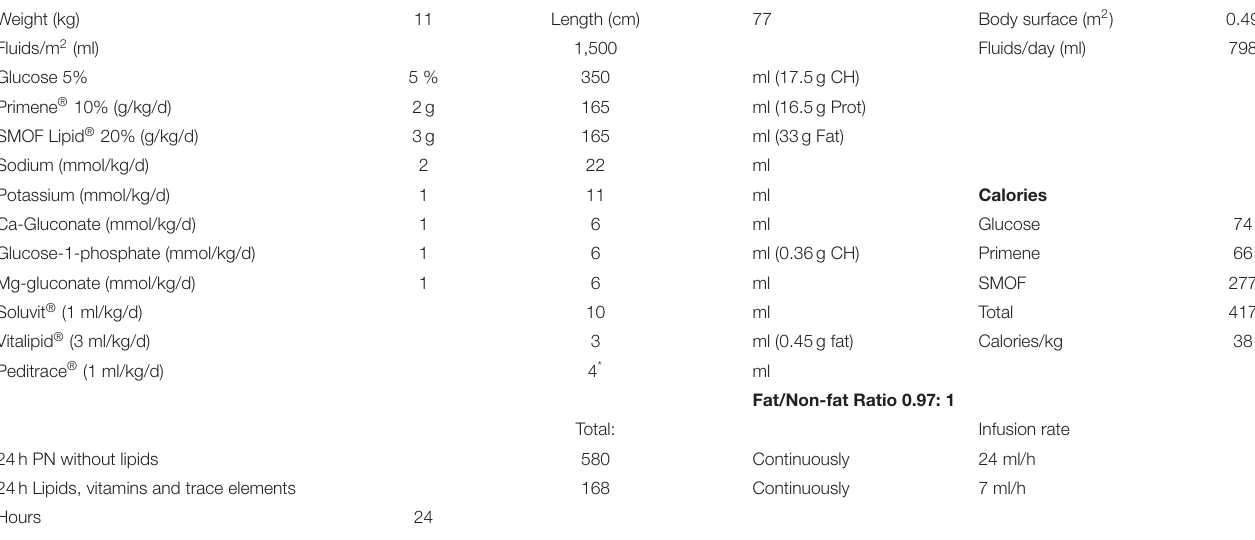
TABLE 1 | Example for the prescription of a ketogenic parenteral nutrition combined with enteral feedings. Weight